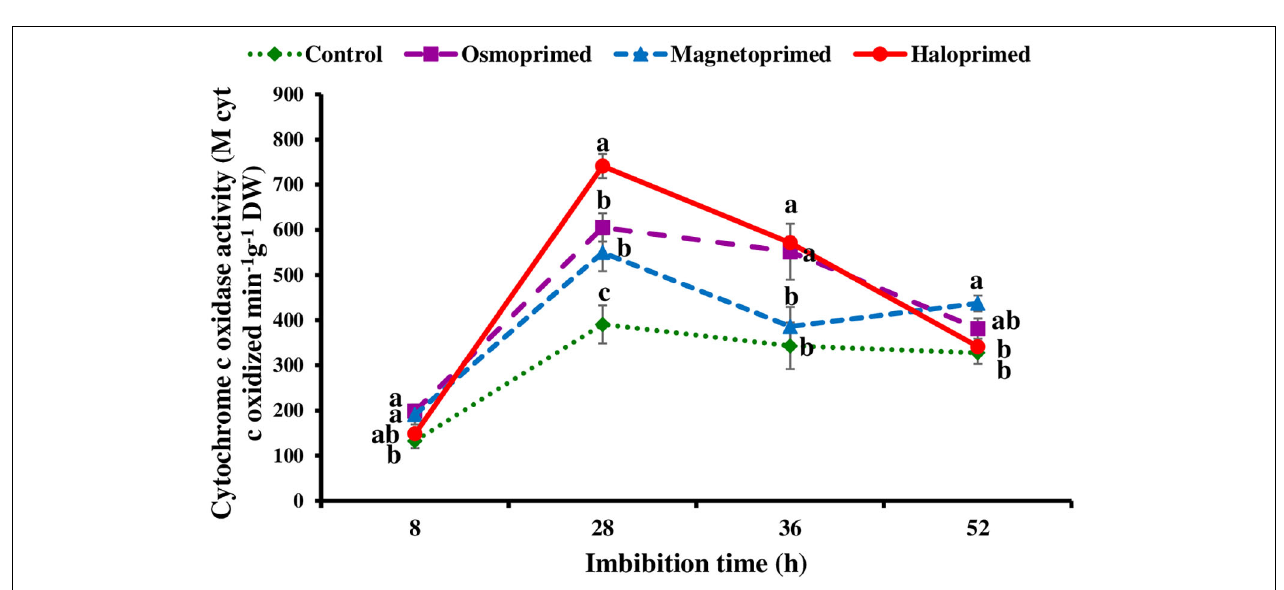
FIGURE 5 | Cytochrome c oxidase activity of differently primed onion seeds at different imbibition time. Data represent mean ± SE of three biological replications. Different letters indicate significant differences among means based on LSD test ( p < 0.05).